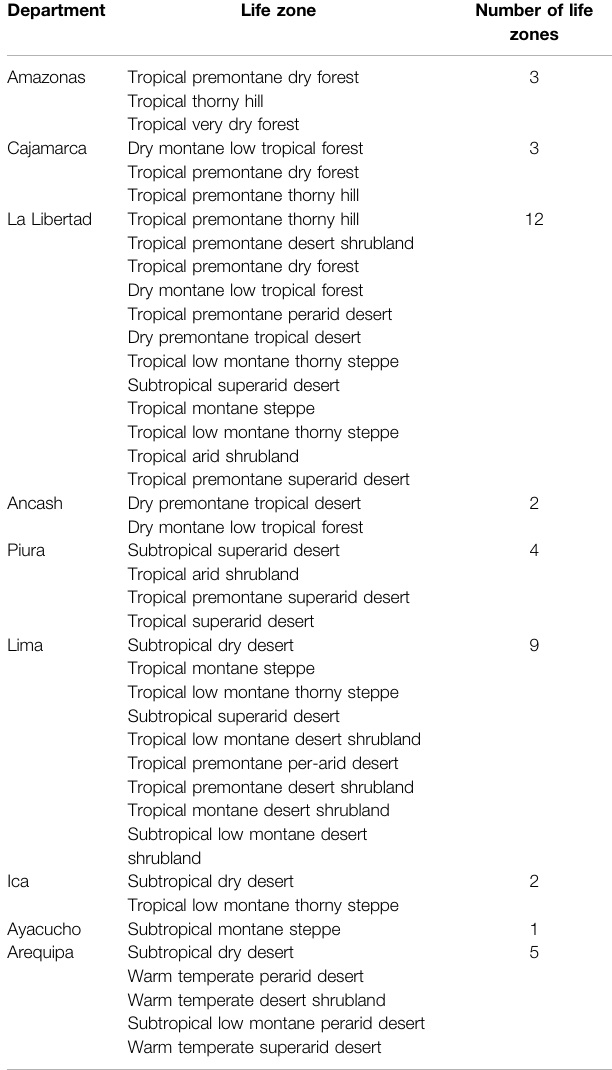
TABLE 1 | Distribution of life zones per department in the 53 studies between years 1992 –